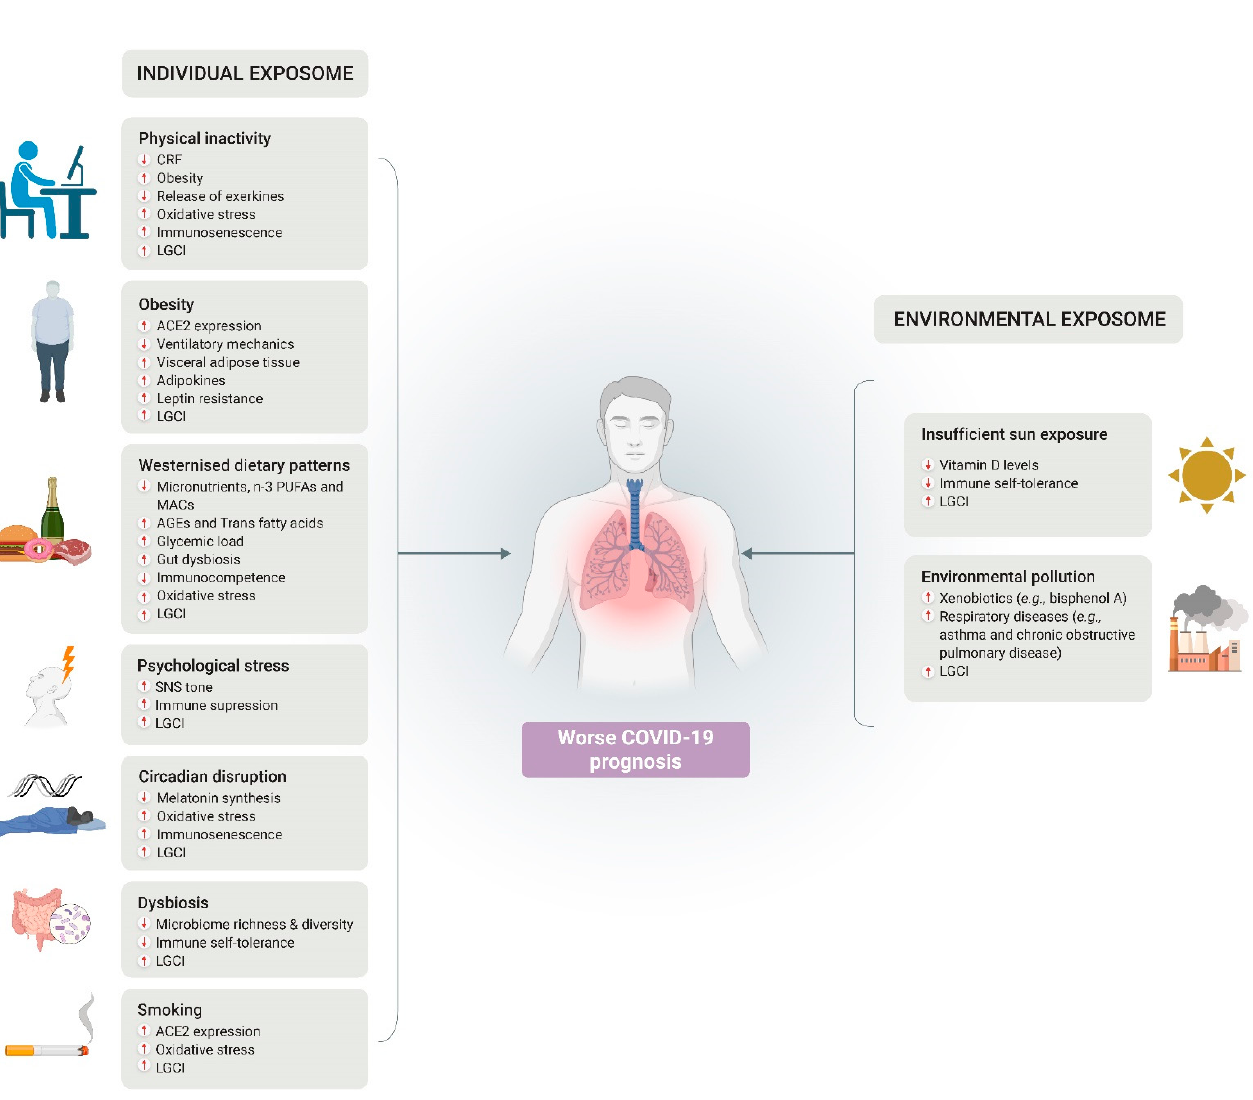
Figure 3. Summary of potential mechanisms underlying the negative effects of the different exposome components on the prognosis of COVID-19. Abbreviations: ACE2, angiotensin converting enzyme-2; AGEs, advanced glycation end products; CRF, cardiorespiratory fitness; LGCI, low-grade chronic inflammation; MACs, microbiota-accessible carbohydrates; PUFA, polyunsaturated fatty acids; SNS, sympathetic nervous system. Source: Self-elaboration based on the main results obtained in the scientific literature.